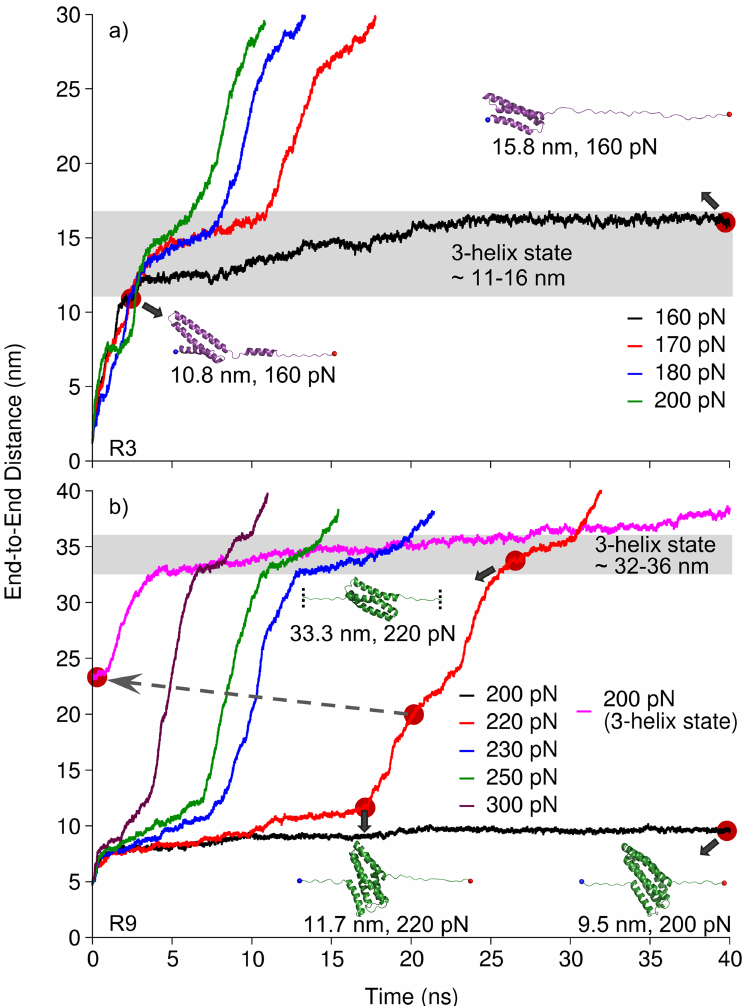
Fig 6. Stability of the intermediate states. Talin rod (a) R3 and (b) R9 over time in constant force SMD using constant force pulling at different force regimes. R9 is a strong 5-helix bundle, while stable 3-helix intermediates were observed in both R3 and R9 (gray shading). The pink trace in panel (b) corresponds to end-to-end distance measured under 200 pN applied force, where 220 pN simulation was used as a starting structure after passing the 5h to 3h transition (dashed gray